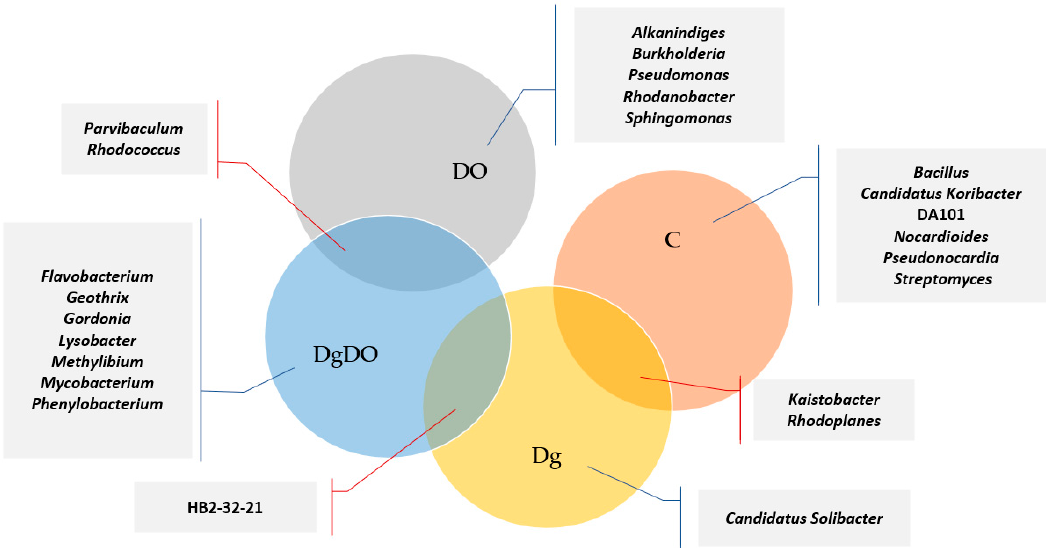
Figure 7. Venn diagram showing unique and common genera of bacteria, based on OTU > 1%.